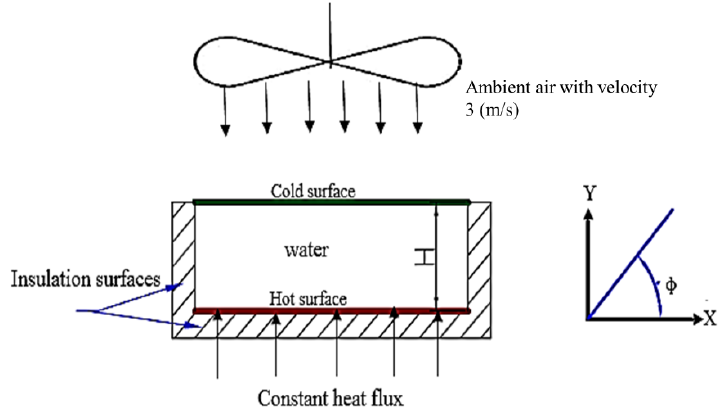
Figure 4. Schematic of the experimental setup with boundary conditions.